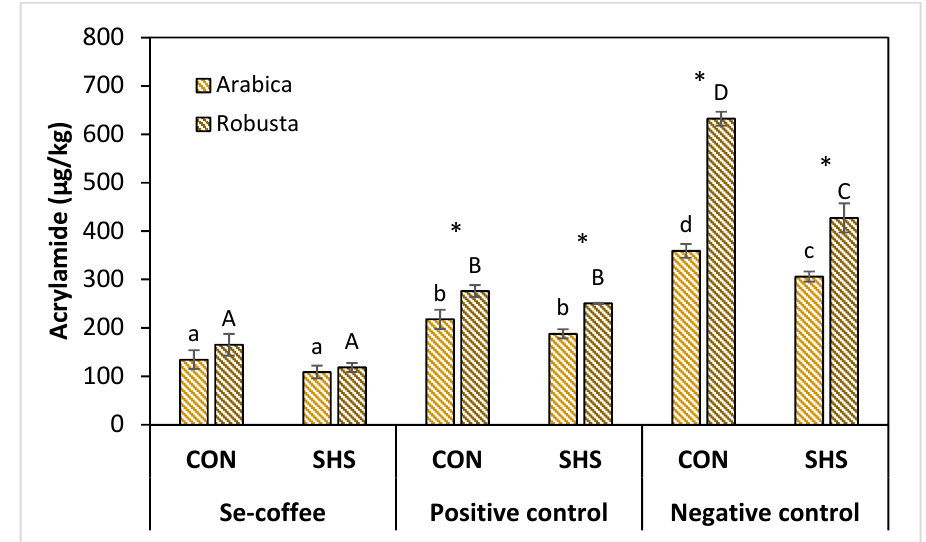
Figure 2. Acrylamide levels in Arabica and Robusta Se-coffee (pretreated with selenium), positive control (pretreated without selenium), and negative control (untreated) roasted via conventional (CON) and superheated steam (SHS) roasting. Lowercase letter, uppercase letter, and star symbol represent significant differences ( p < 0.05) between different treatments for Arabica, Robusta coffees, and significant differences ( p < 0.05) between the coffee varieties, respectively.